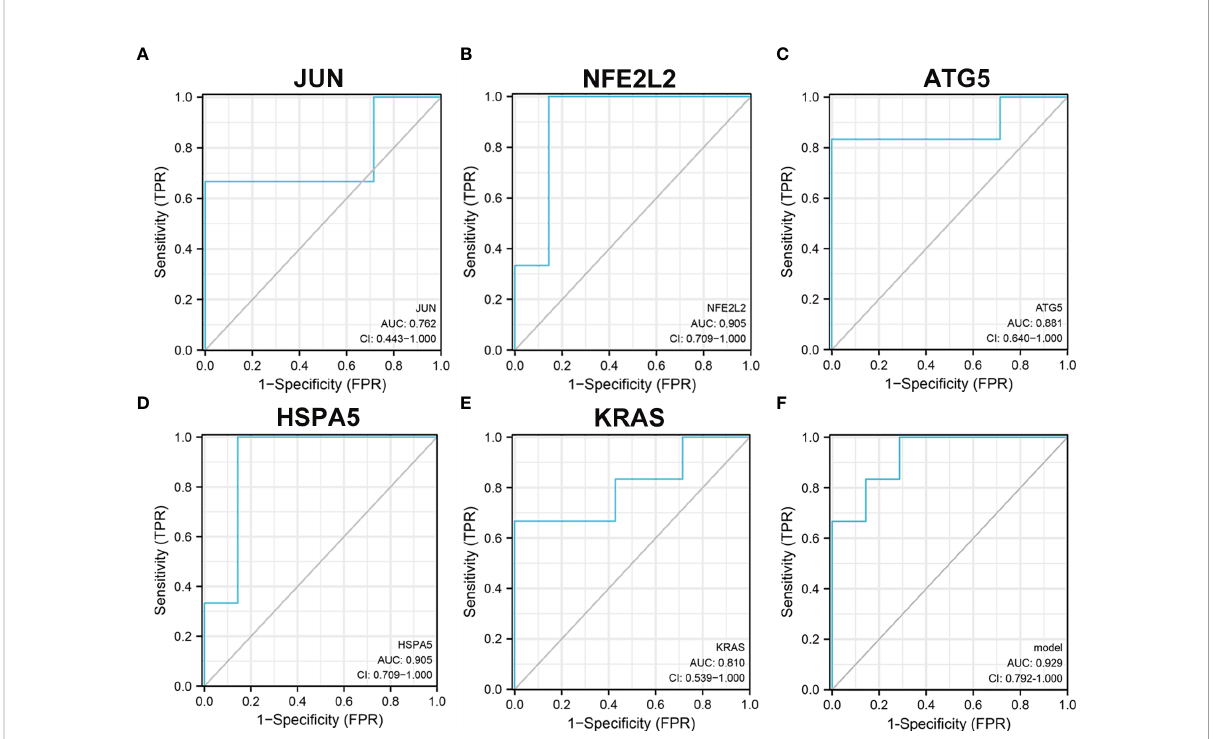
FIGURE 9 Receiver operating characteristic analysis revealed the predictive performance of ferroptosis-related hub genes for T2D. (A) The AUC of JUN (A) , NFE2L2 (B) , ATG5 (C) , KRAS (D) , and HSPA5 (E) in ROC monofactor analysis. (F) The AUC of fi ve ferroptosis-related hub genes in the logistic regression model. Receiver operating characteristic, ROC; AUC, area under the ROC curve.